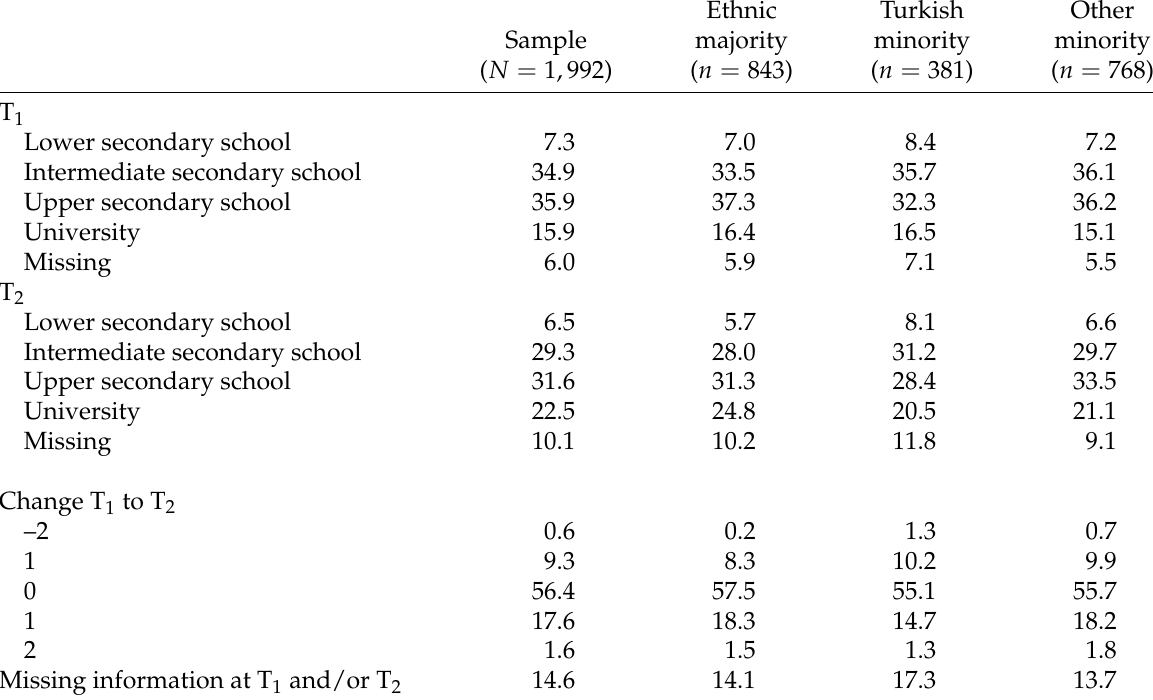
Table 1: Educational expectations (%) in the analytic sample by ethnic